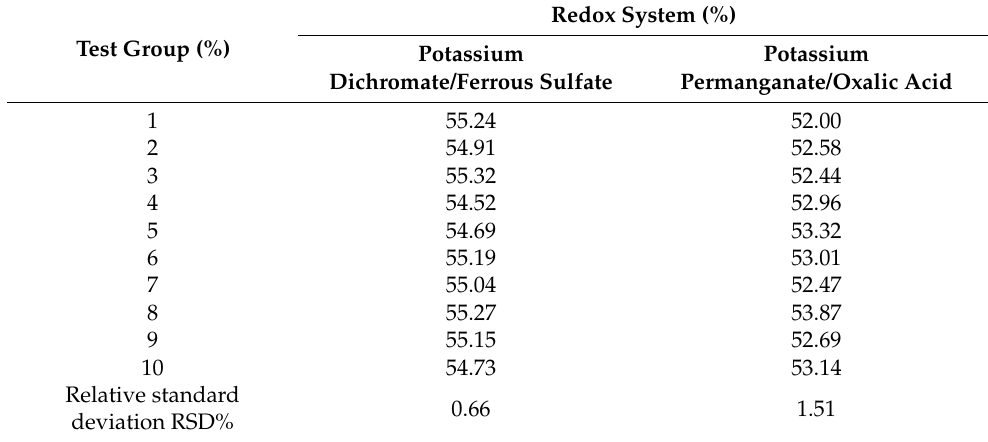
Table 1. Comparison of bioassimilated carbon content in two redox systems.